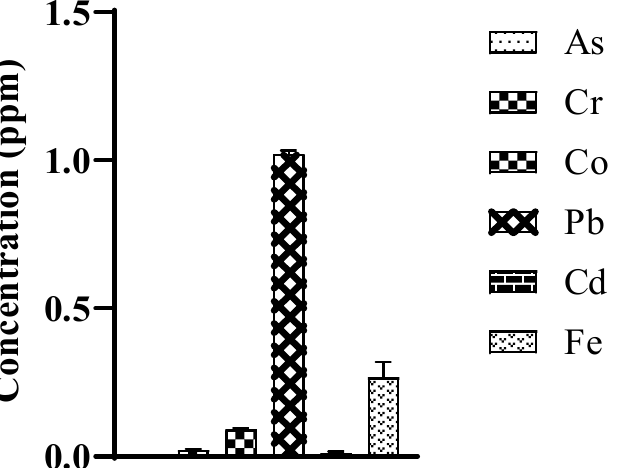
Figure 2. Heavy metal concentration (ppm) present in M-Ext analyzed through atomic absorption spectroscopy. Data was shown as means ± SD ( n =